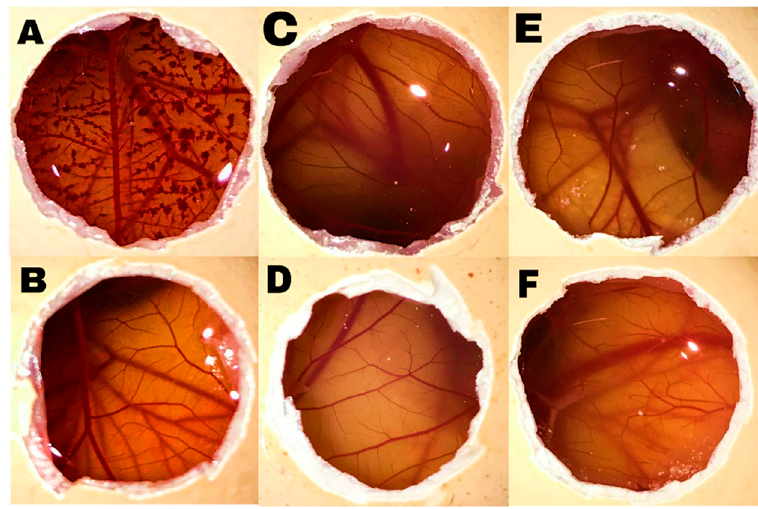
Figure 3. Effect of controls and test substances on the surface of the chorioallantoic membrane (CAM) after treatment for 3 min ( A ) NaOH 0.1 N, ( B ) NaCl 0.9% w / w , ( C ) Soluplus (16%), ( D ) Soluplus (20%), ( E ) Pluronic F68 (16%), and ( F ) Pluronic F68 (20%) dispersions in a PBS.